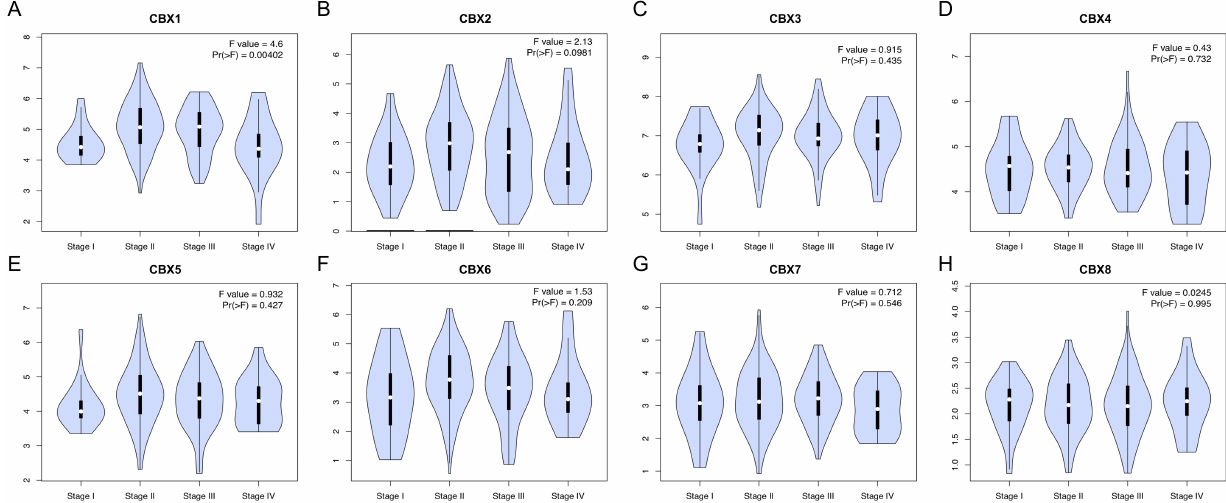
Figure 2. Relationships between the expression of CBX family proteins and clinical stages of EC ( A – H ). (GEPIA2, p < 0.05 was considered statistically significant). CBX1 expression was related to pathological stages of EC